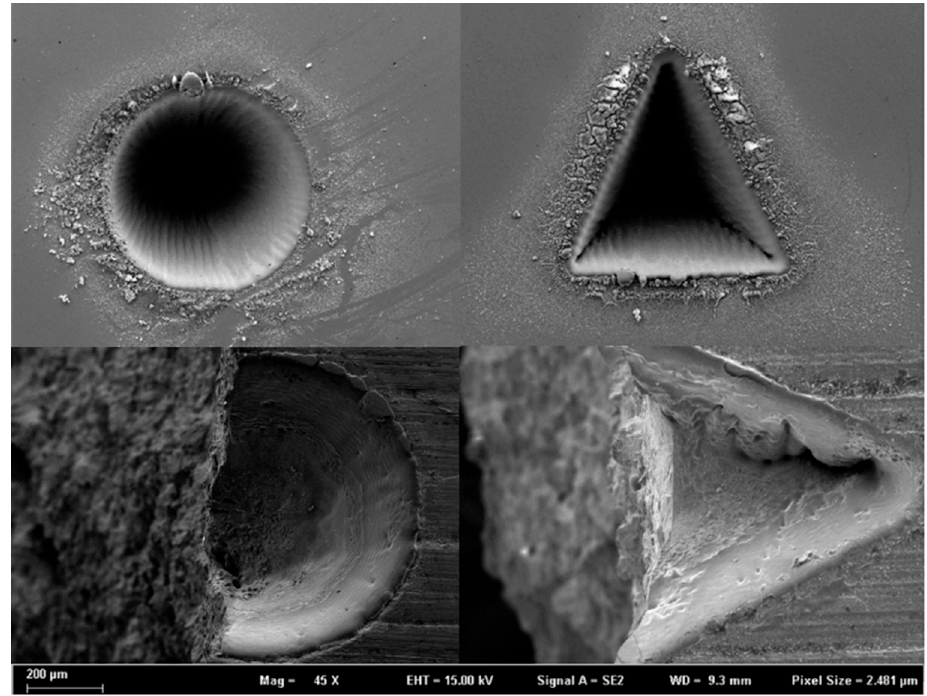
Figure 13. Morphologies of the blind holes before and after fracture.